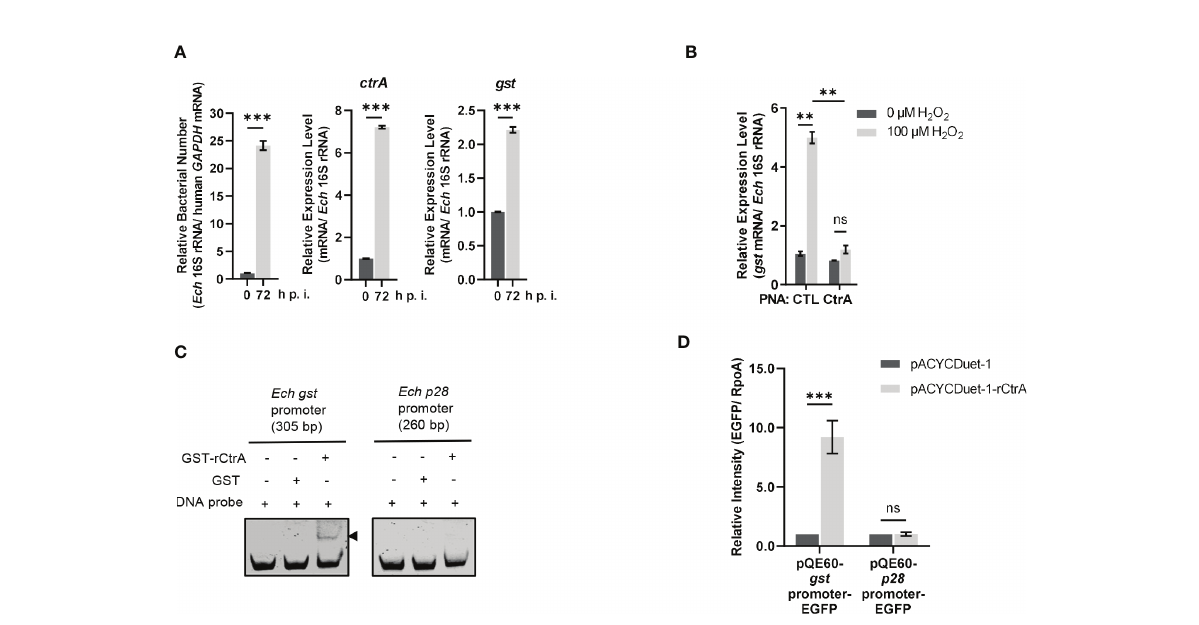
FIGURE 2 CtrA binds to the gst promoter region and activates the gst expression upon oxidative stress. (A) The expression levels of ctrA and gst and relative bacterial numbers at different stages of E. chaffeensis intracellular growth. RNA samples were prepared from synchronously cultured E. chaffeensis in THP-1 cells at 0 h and 72 h p.i. The expression level of each gene was determined with qRT-PCR and normalized against that of E. chaffeensis 16S rRNA. Relative bacterial number was determined as the amount of bacterial 16S rRNA normalized against that of human GAPDH mRNA. Relative values to the amount at 0 h p.i. are shown. Data indicate means ± standard deviations ( n = 3). The signi fi cant differences are represented by P -values determined with Student ’ s t test (*** indicates P < 0.001). (B) CtrA activates the gst expression in E. chaffeensis upon oxidative stress. At 36 h p.i. THP-1 cells synchronously infected with CTL PNA- or CtrA PNA-transfected E. chaffeensis were treated with H 2 O 2 at a fi nal concentration of 100 m M or culture medium (CTL) at 37°C for 2 h. The gst expression level was determined with qRT-PCR and normalized against that of E. chaffeensis 16S rRNA. Relative values to the gst amount of CTL PNA-transfected E. chaffeensis without H 2 O 2 treatment are shown. Data indicate means ± standard deviations (n = 3). The signi fi cant differences are represented by P -values determined with Student ’ s t test (ns indicates P > 0.05, and ** indicates P < 0.01). (C) CtrA binds to the gst promoter. DNA probe (50 ng) was incubated alone, with GST (2.5 µM) or with GST-rCtrA (2.5 µM) on ice for 30 min. Shifted band is indicated by an arrowhead. The p28 promoter region is shown as a negative control. The length (bp) of the probe is shown above each panel. (D) CtrA activates the gst expression. E. coli BL21 (DE3) cells grown to an OD 600 of 0.4 were induced to express rCtrA with 0.05 mM IPTG at 37 °C for 3 h. The amount of EGFP or RpoA was determined using Western blotting. The relative intensities of EGFP to those of RpoA were measured by Image J and calculated by setting the value of bacteria containing pACYCDuet-1 and corresponding pQE60-promoter-EGFP fusion construct as 1. Data indicate means ± standard deviations ( n = 3). The signi fi cant differences are represented by P -values determined with Student ’ s t test (ns indicates P > 0.05, and *** indicates P <